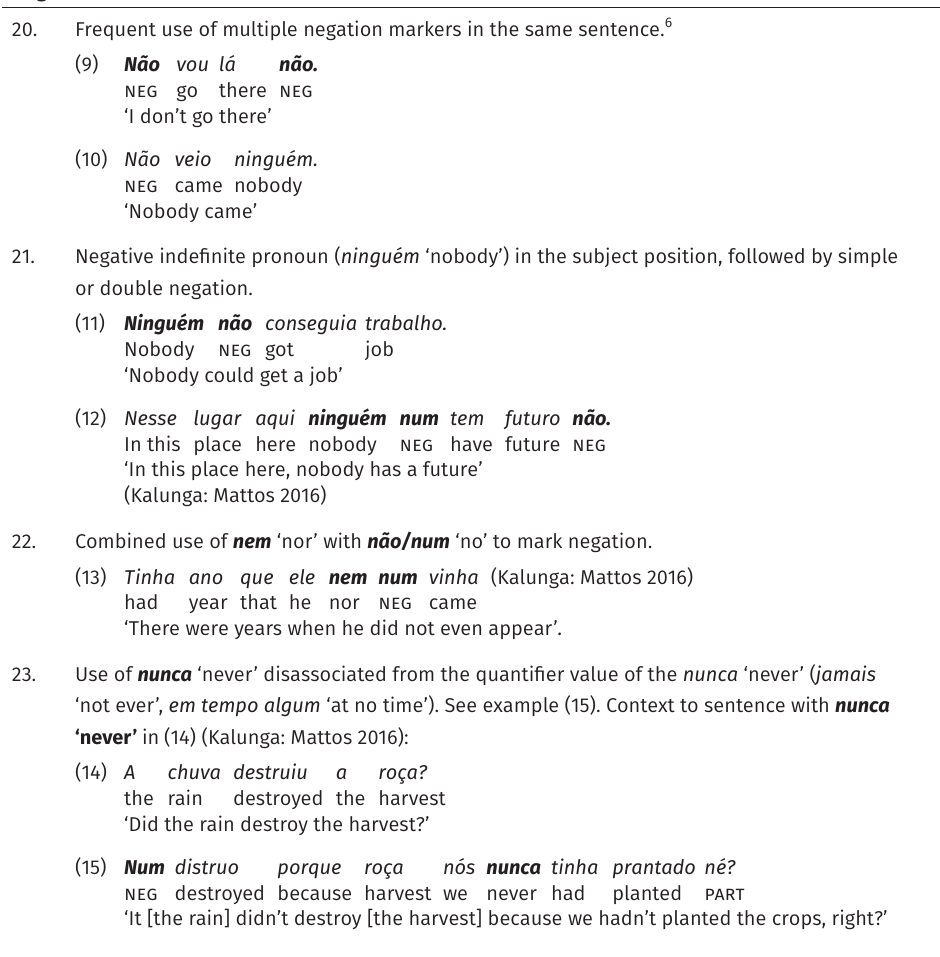
Table 4: Examples of features related to Negation, extracted and translated from the Dialectal Features